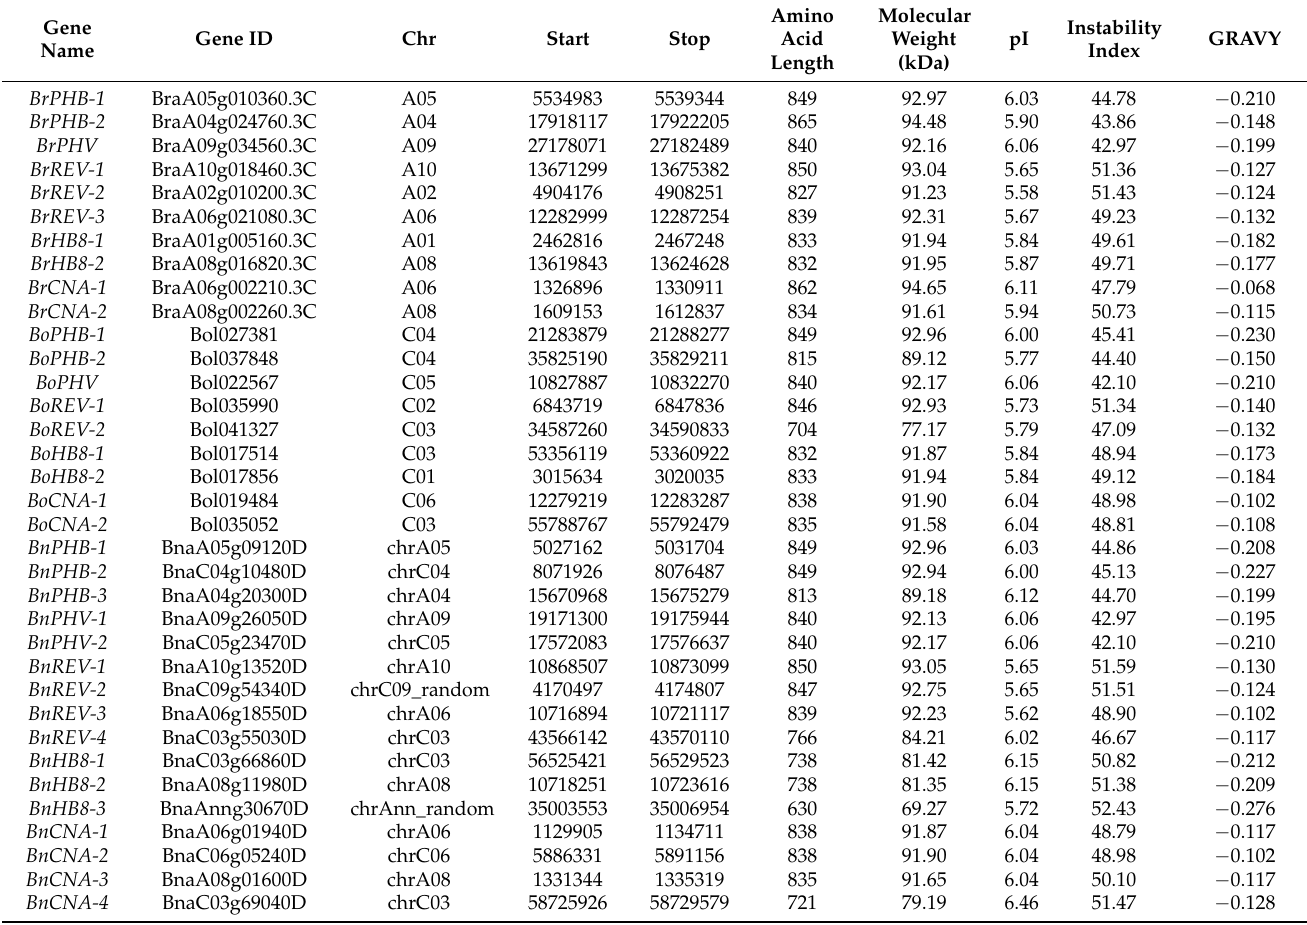
Table 1. Identification and characterization of HD-ZIP III genes in B. rapa , B. oleracea and B. napus